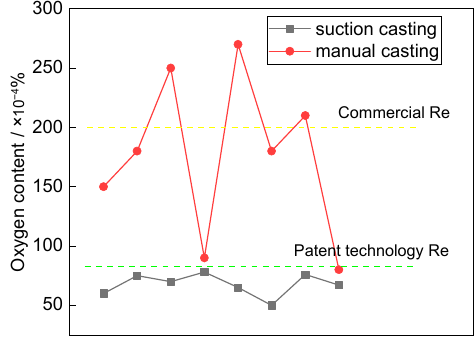
Figure 3. Effect of casting method on oxygen concentration.